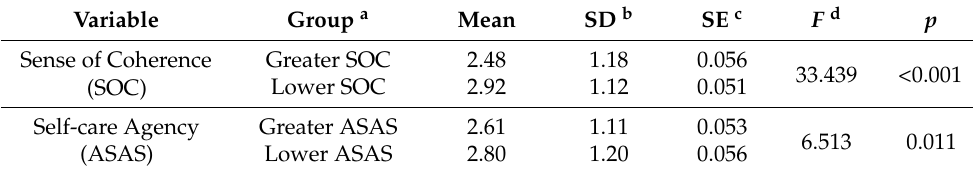
Table 4. One-way ANOVA tests for academic performance, grouping participants by the SOC and ASAS